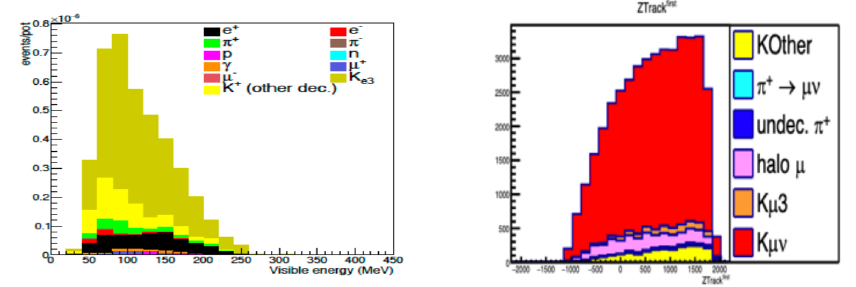
Figure 3. Reconstructed visible energy of K e 3 positron events (left) and reconstructed impact point along decay tunnel calorimeter wall (Z) of K µν (right) after the application of the Neural